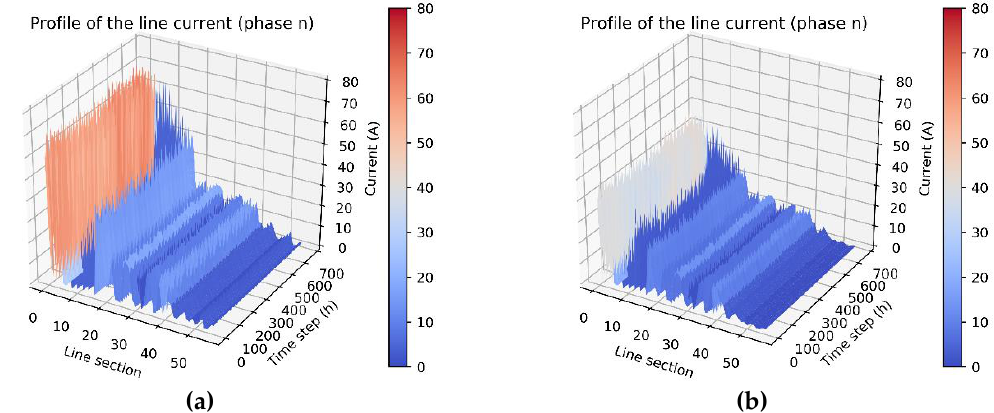
Figure 12. The neutral current spread and PDF of neutral current: ( a ) before rephrasing and ( b ) after rephasing.